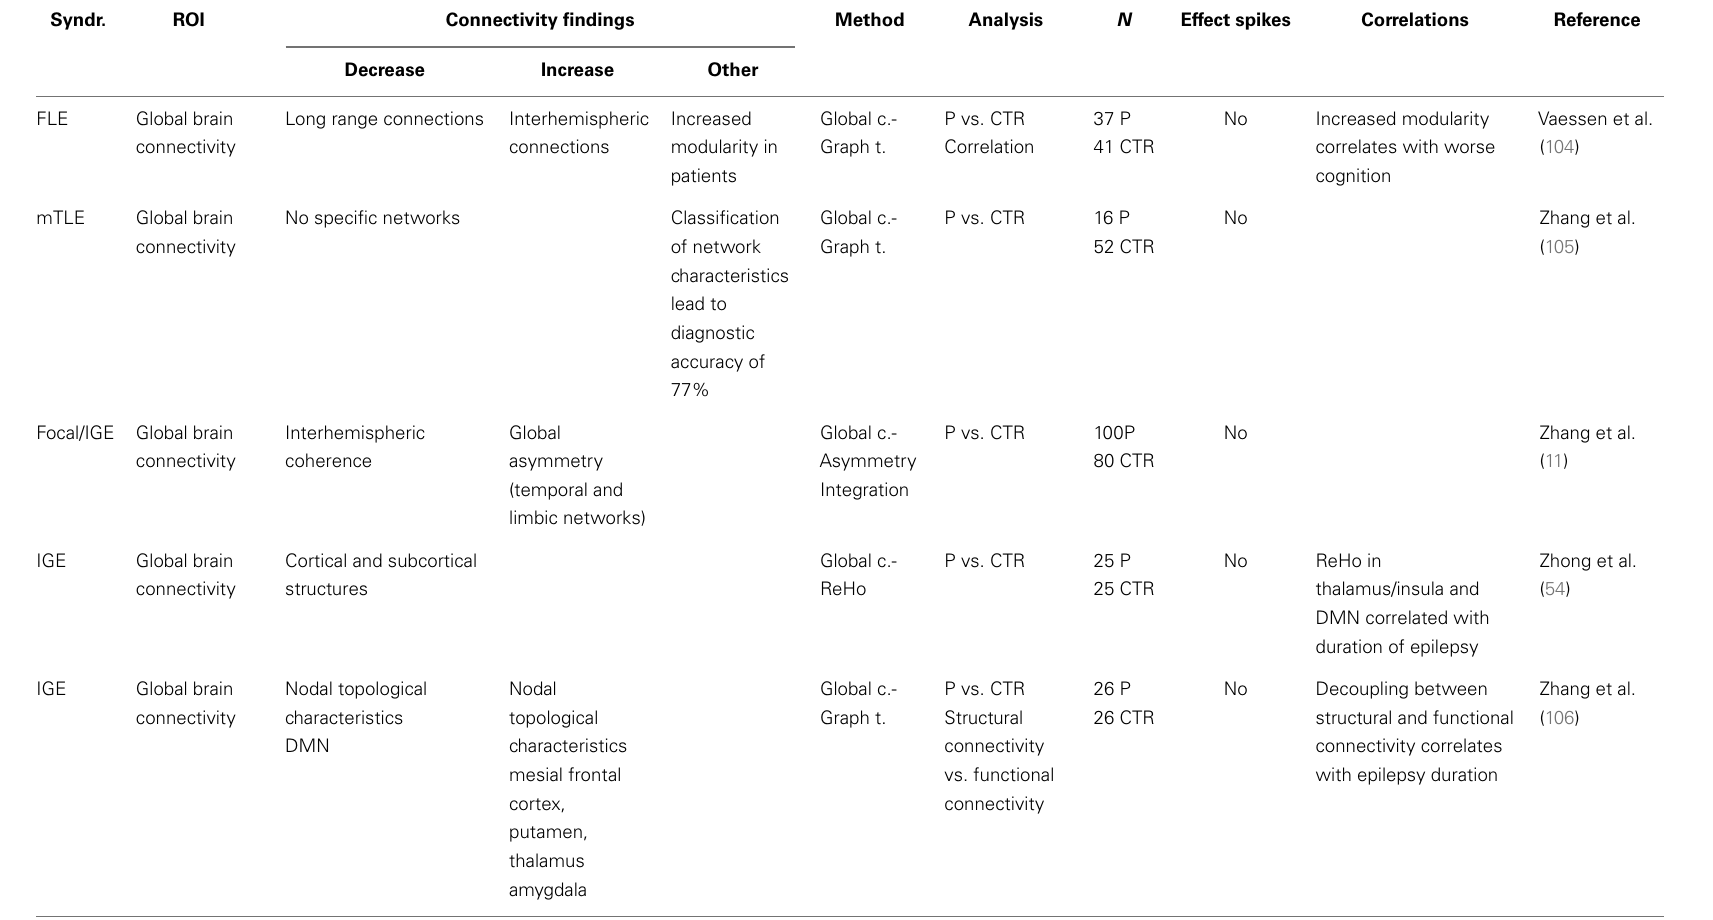
Table 3 | Resting state studies in epilepsy reporting abnormalities of global brain connectivity .